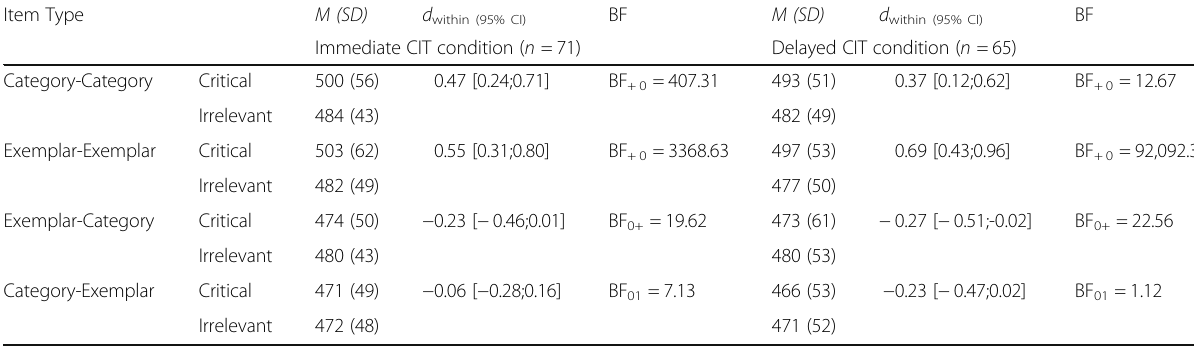
Table 1 Mean reaction times (in ms) for the immediate and delayed condition per Item Type Item Type